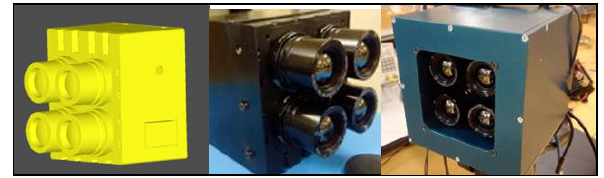
Figure 7. MULTICAM Infrared camera for UAS: from the design to the system